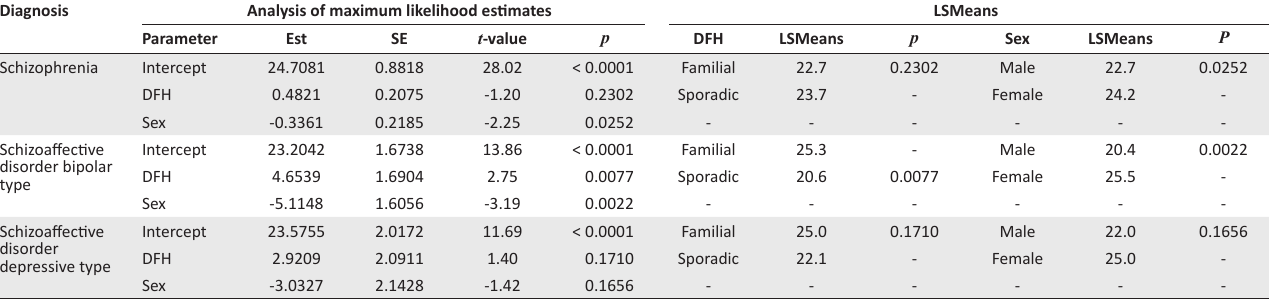
TABLE 3-A1: General linear models for different diagnosis; age at onset as outcome variable and predictors entered are differential family history and sex.